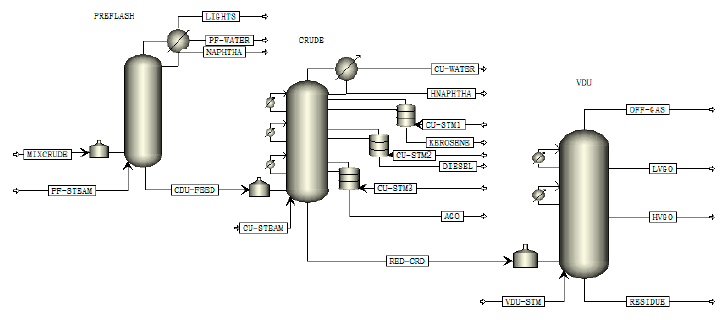
Figure 1. An industrial nonsharp distillation sequence.